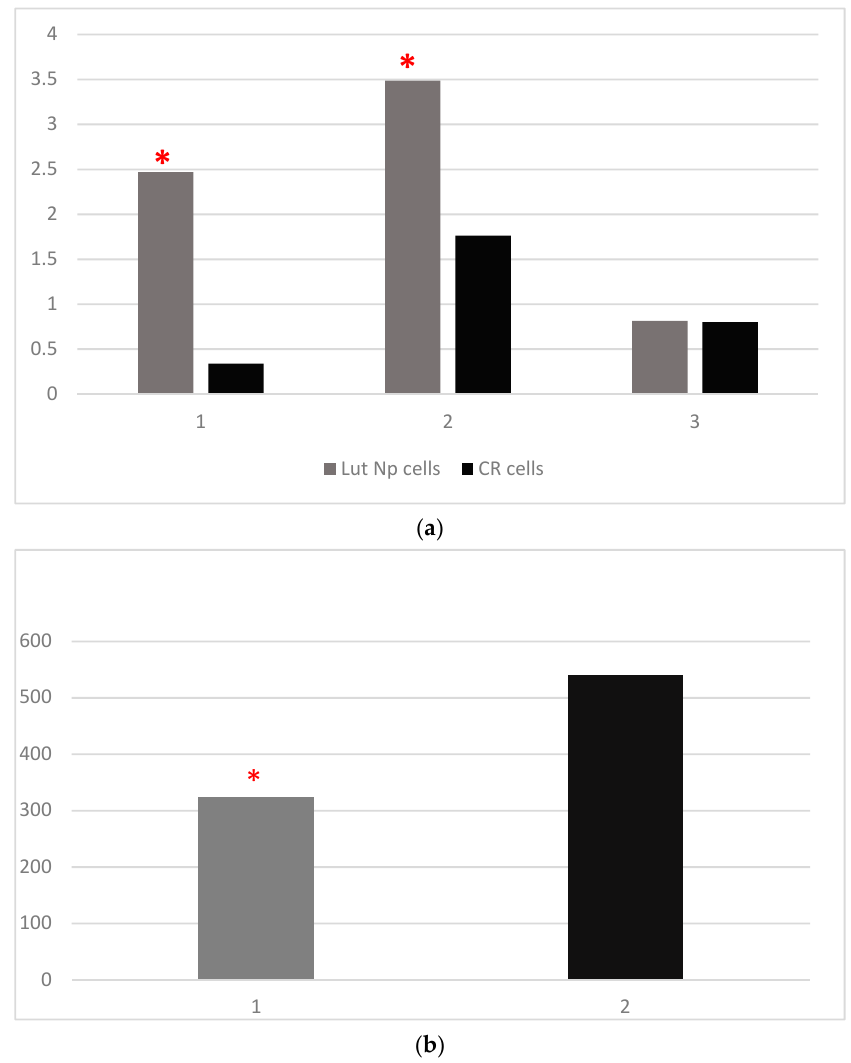
Figure 3. ( a ) Mean values of OXSR1 (mg/mg protein), TAC (ng/mg protein), FOXO-3 (ng/mg protein) in lutein nanoparticles-treated oral cancer cells, and control cells (Lut Nps—oral cancer squamous cells incubated with lutein nanoparticles; CR—control oral cancer squamous cells): 1- OXSR-1, 2-TAC, 3-FOXO-3; * indicates a statistically significant difference. ( b ) Mean values of MMP-9 (pg/mg protein) in lutein nanoparticles-treated oral cancer cells, and control cells (Lut Nps—oral cancer squamous cells incubated with lutein nanoparticles-1; CR—control oral cancer squamous cells-2). * indicates a statistically significant difference.